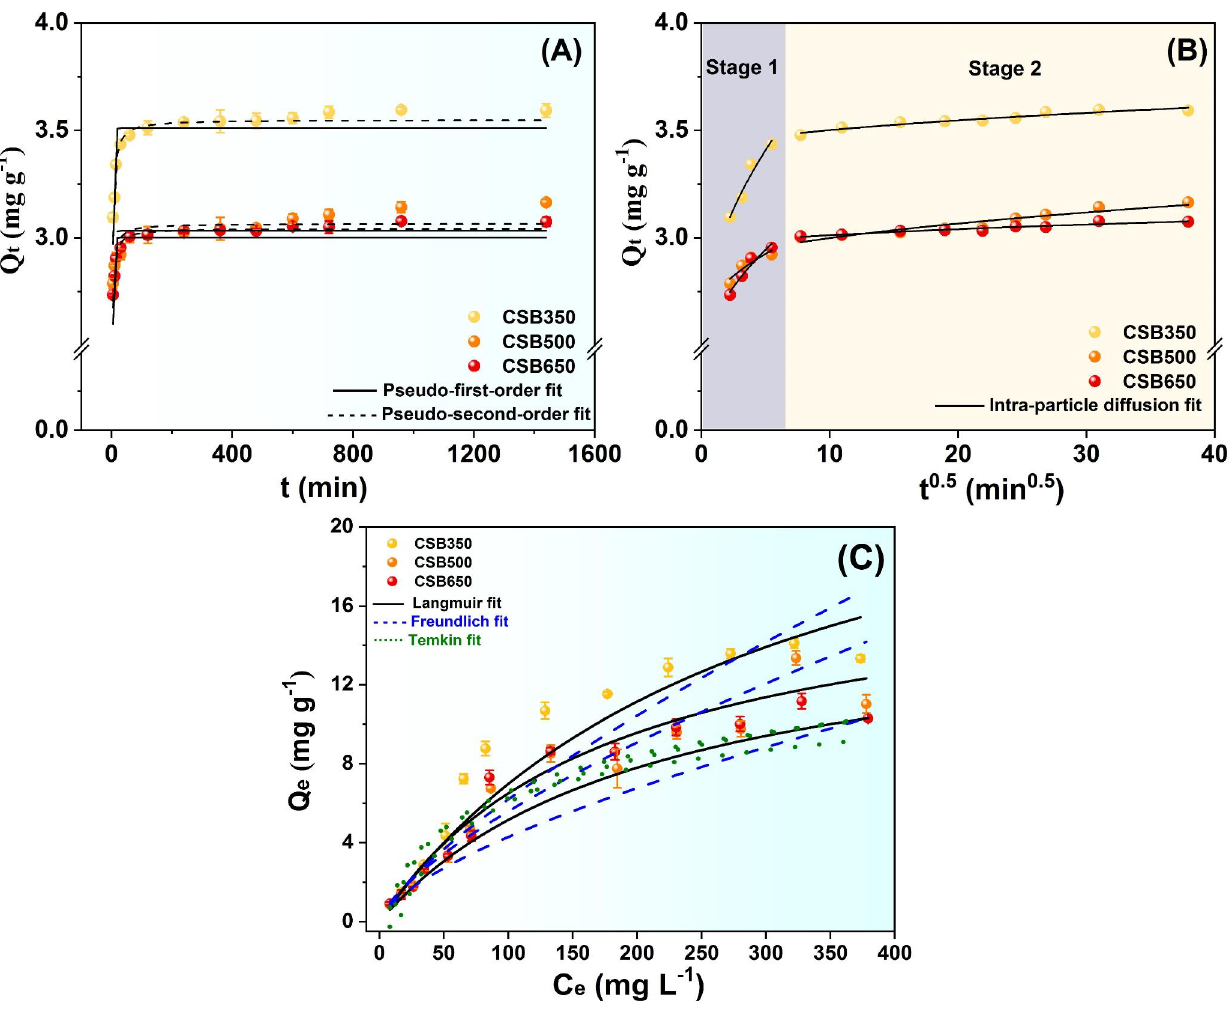
Fig. 3 Adsorption kinetics of Sb(III) on crawfish shell biochar (CSB) pyrolyzed at 350 ° C (CSB350), 500 ° C (CSB500), and 650 ° C (CSB650) using pseudo-first-order, pseudo-second-order (A), and Intra-particle diffusion models (B); adsorption isotherms of Sb(III) on the CSB